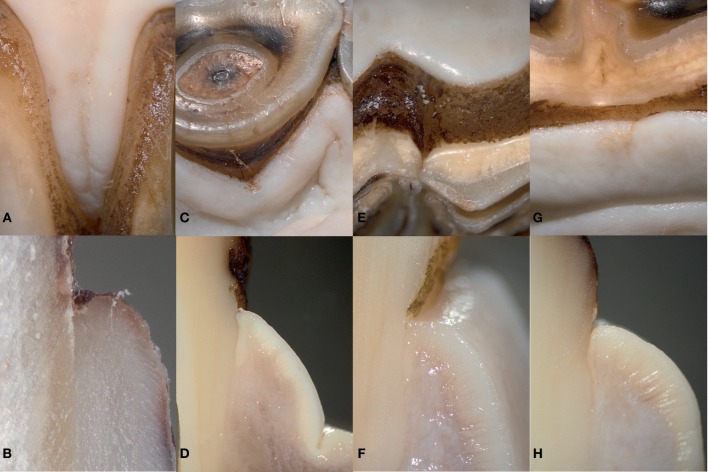
The equine gingiva is tightly attached to the tooth. (A,C,E,G): macroscopic appearance of the equine gingiva in the incisor (A,B) and cheek teeth region (E,G). (B,D,F,H): corresponding transverse section. The gingiva is directly attached to the dental cementum featuring a gingival sulcus of less than 1 mm.